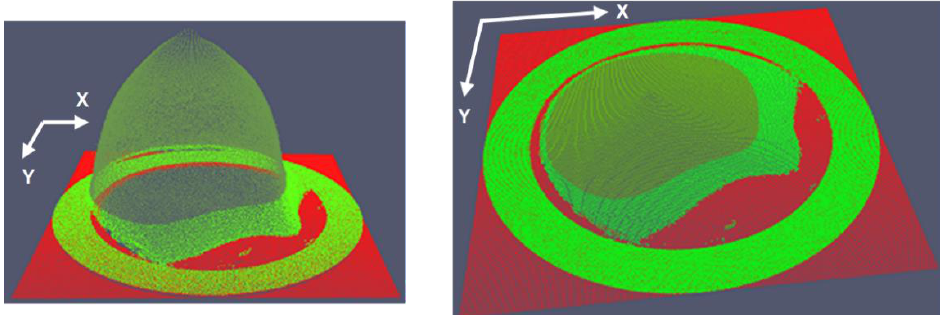
Figure 21. Valid points (green points) of the rectangular grid divided into two sections (bright green and dark green) by using the ring height parameter, in the non-stretched point cloud (left-hand image) and in the stretched point cloud 𝑃𝑐 𝐷 (right-hand images). Illustration on Patient 002.